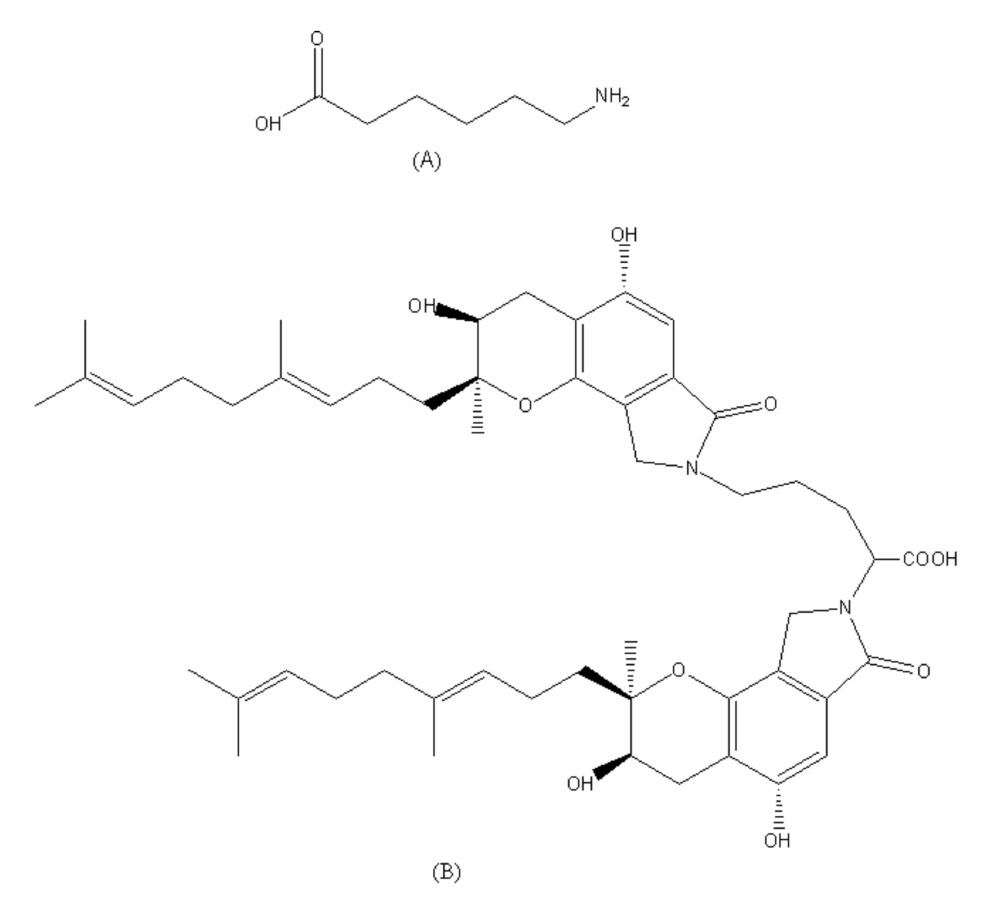
Figure 6. Chemical structures of EACA ( A ) and FGFC1 ( B ) . The same protein orientation was used to compare the binding models of EACA and FGFC1 to the same kringle domain. As shown in Figure 7, the binding position of FGFC1 to KR1–KR5 partially overlapped with that of EACA according to a comparison and analysis of their binding